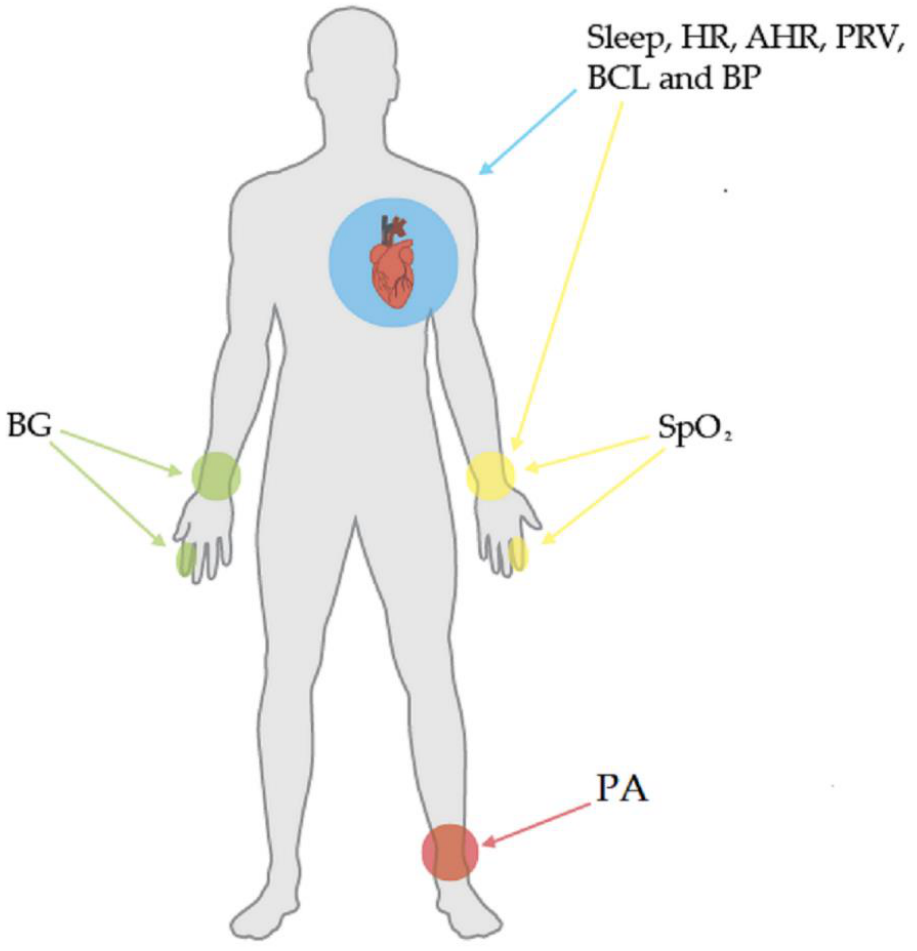
Figure 1. Common biomedical variables and associated body parts. Heart rate ( HR ). It refers to the number of times the heart beats in one minute.